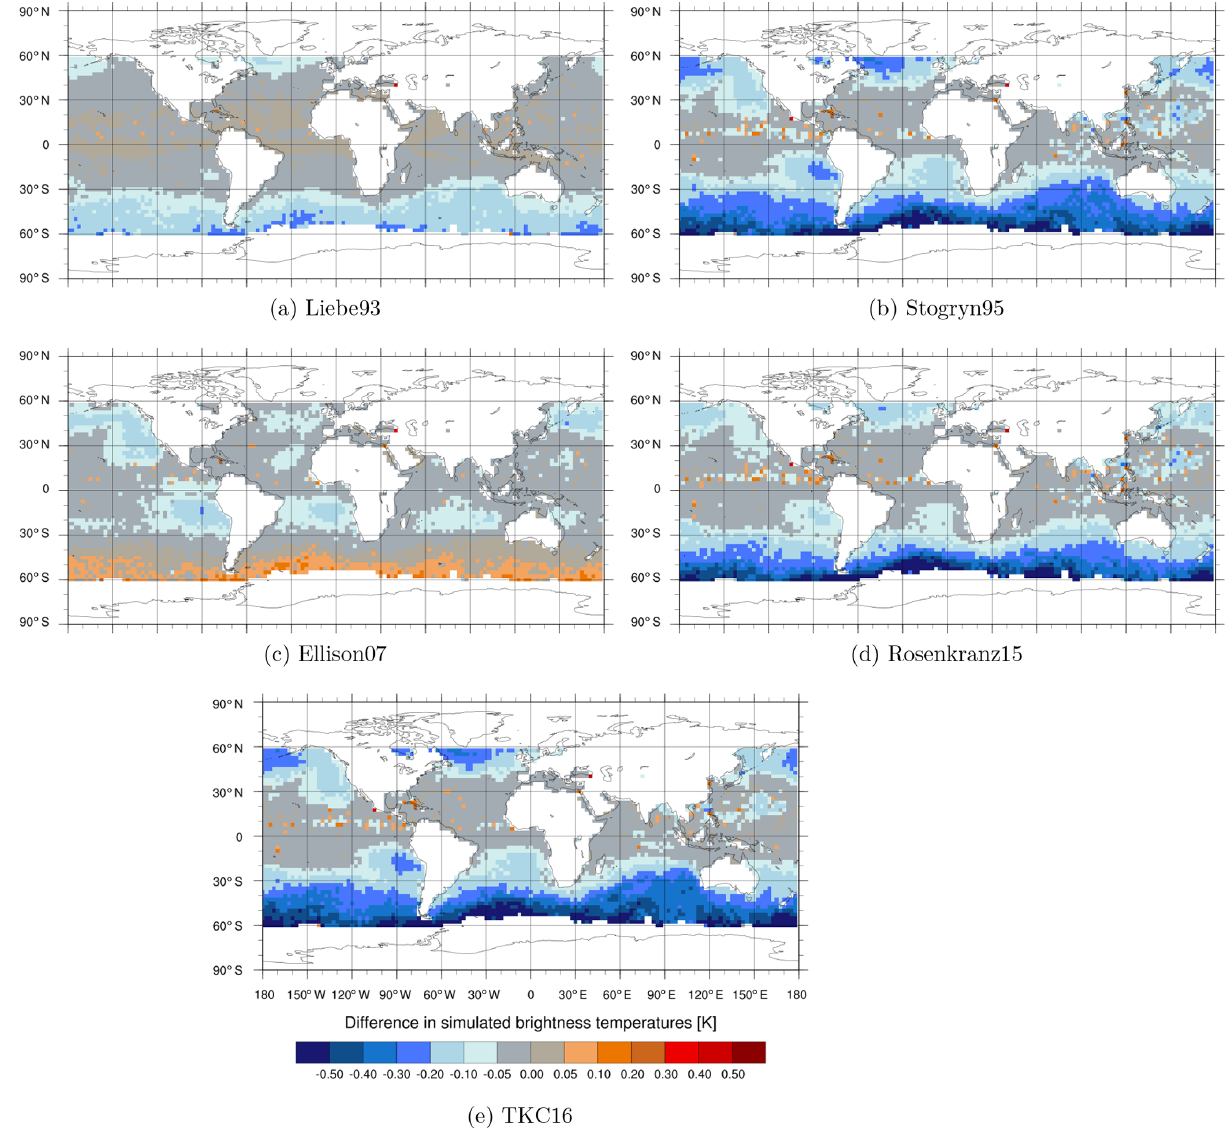
Figure 4. As in Fig. 3 but for channel